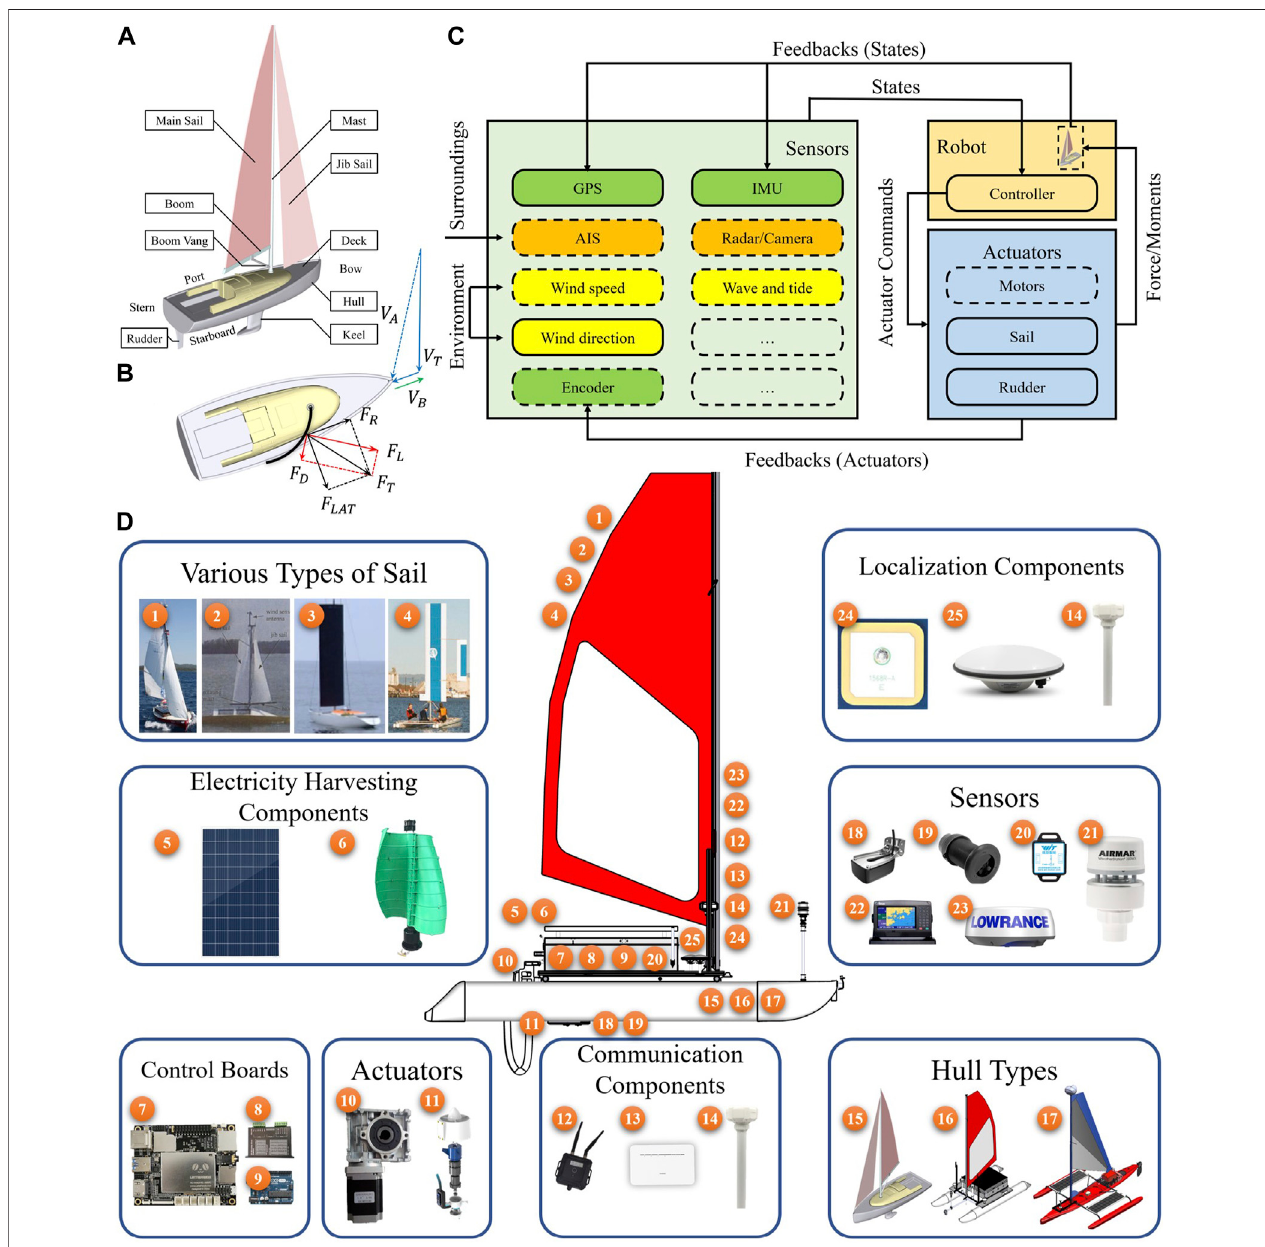
FIGURE 1 | Basic system structure of sailing robots. (A) Mechanical structure. (B) Sail force analysis. (C) General control scheme. (D) Typical architecture. In varioustypes ofthesail, 1 – 4aresoft sail,soft sailwithabalancedrig, wing-sail, andwing-sailwithself-trimming,respectively. Forelectricityharvesting,thesailingrobots areequipped withasolarpanelandwindgeneratorin5,6.Incontrolboards, therearemaincontrolboard, motordriverboard, andmicro-controlboardforI/Osignalsin 7 – 9. Actuators include stepper motors for the sail and rudder and propeller motors in 10, 11. The communication methods consist of wireless radio station, 4G cellular module,and satellite communication station in 12 – 14. Based on the hull types, the sailing robot canbe divided into monohull, catamaran, and trimaran sailboats in 15 – 17. Classical sensors include underwater sonar, wave current sensor, inertial measurement unit (IMU), weather station, automatic identi fi cation system (AIS), and radar with labels 18 – 23, respectively. The localization systems include Global Positioning System (GPS), Real-time kinematic GPS (RTK-GPS), and radio determination satellite system (RDSS) in 24, 25, and 14.